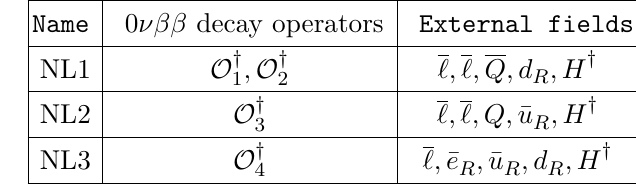
Table 1 . The fields involved in the 0 νββ decay operators, the hermitian conjugate operators are used to accommodate our